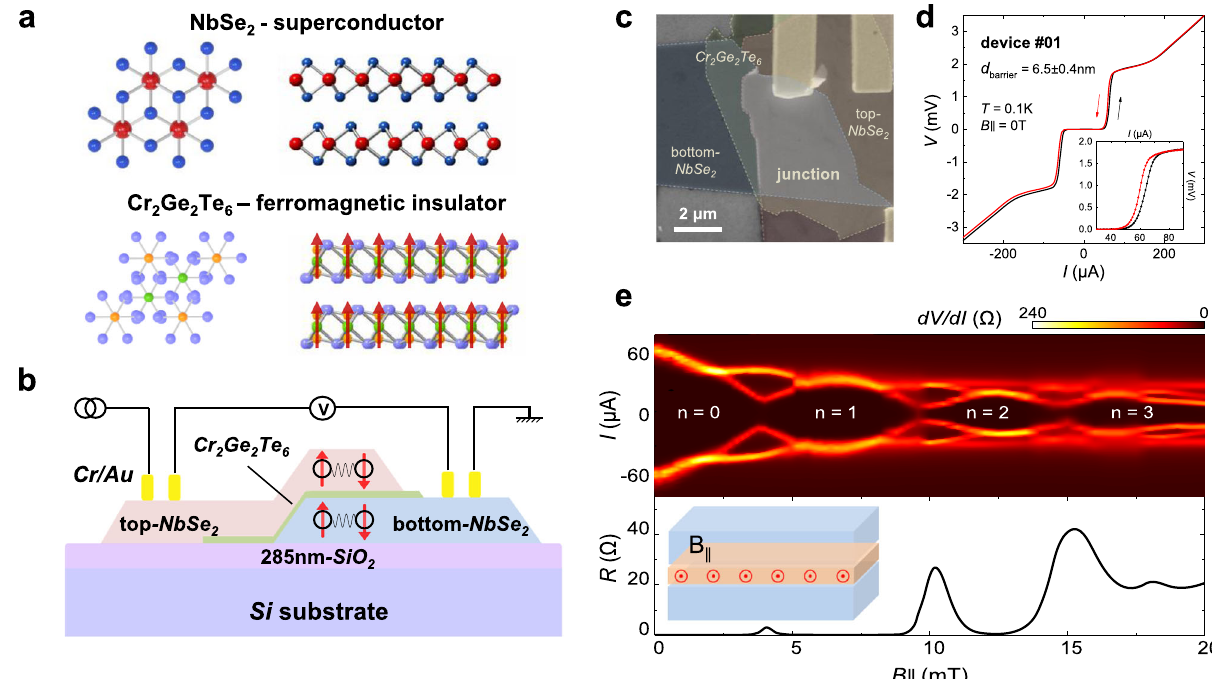
Fig. 1 Device structure and basic characterizations of vdW Josephson junctions based on NbSe 2 and Cr 2 Ge 2 Te 6 fl akes. a Crystal structures of superconductor 2H-NbSe 2 (Nb, red and Se, blue) and ferromagnetic insulator Cr 2 Ge 2 Te 6 (Cr, green, Ge, orange and Te, purple). The top and side views show their layered structures. Red arrows in Cr 2 Ge 2 Te 6 indicate the magnetization. b Schematic illustration of the junction with the measurement con fi guration. A four-terminal measurement on the laminated vertical structure is performed. c False-color scanning electron microscope (SEM) image of device #01 (scale bar: 2 μ m). The three layers are labeled by the dash lines, respectively, and the junction area is ~14.2 μ m 2 . d Typical current-voltage IV curve of JJ (device #01) at 0.1 K under zero magnetic fi eld with the charge (black) and retrap (red) situation. The thickness of the barrier is ~ 6.5 nm measured by atomic force microscope (AFM). The inset is a zoom-in plot of its IV curves. e Differential resistance d V/ d I map as a function of bias current I and in-plane magnetic fi eld with a periodically oscillatory junction resistance, showing a Fraunhofer pattern. Besides, higher-order oscillations due to Fiske resonance indicate a highly transparent junction surface.